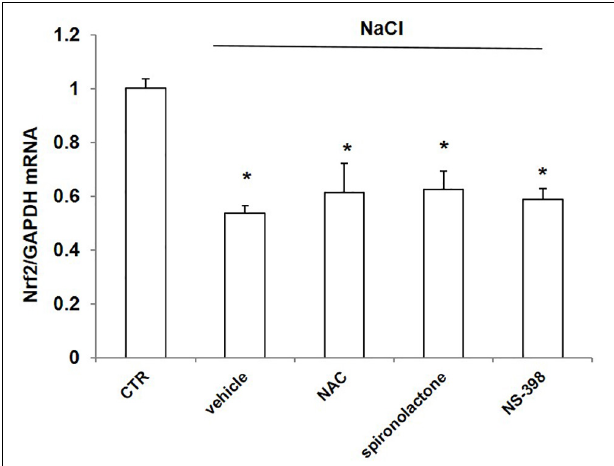
FIGURE 8 | mRNA expression of Nrf2 in mpkCCD cells after treatment of NaCl in combination with NAC, spironolactone, or NS-398 treatment. All groups were treated with NaCl except CTR (control) group. NAC: N-acetylcysteine. The Nrf2 mRNA expression was determined by qRT-PCR. The presented data are means ± SE. n = 3 per group. ∗ p < 0.05 vs. CTR